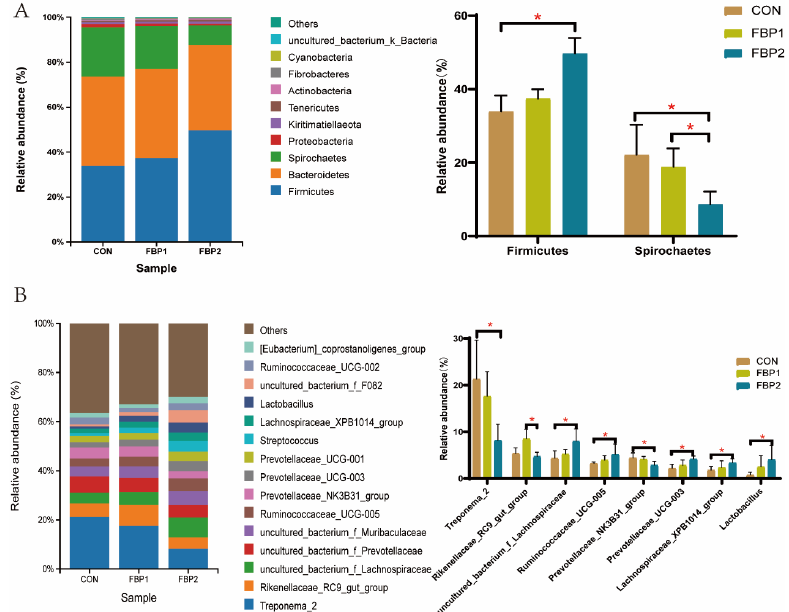
Figure 2. Composition of the bacteria at the level of phylum (top 10, ( A )) and genus (top 15, ( B )). The left side of the figure shows the composition of the bacteria at each level, and the right side shows the differential bacteria at each level. CON, control diet. FBP1, the 5% fermented bamboo powder supplementation diet. FBP2, the 10% fermented bamboo powder supplementation diet. * indicates statistically significant difference (p < 0.05).